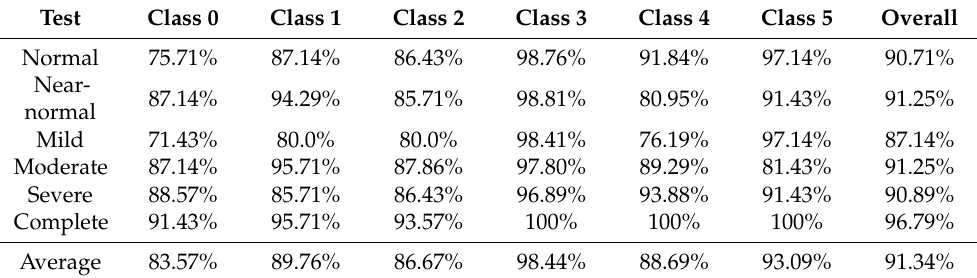
Table 5. The results per class for each level of paralysis of the facial gesture recognition